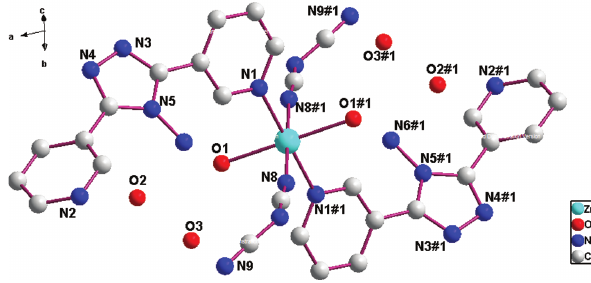
Table 1: Data collection and